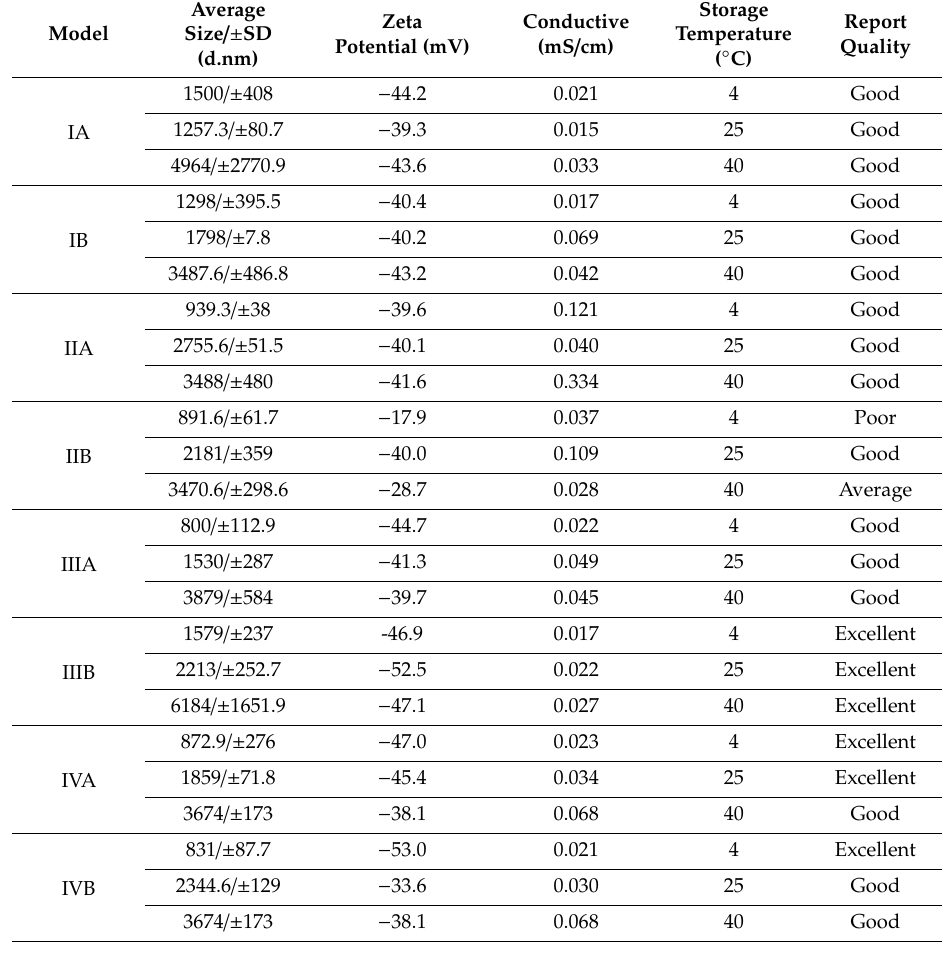
Table 3. Globule size and zeta values of model IA to IVA and their controls at 4 ◦ C, 25 ◦ C and 40 ◦ C after 8 days.